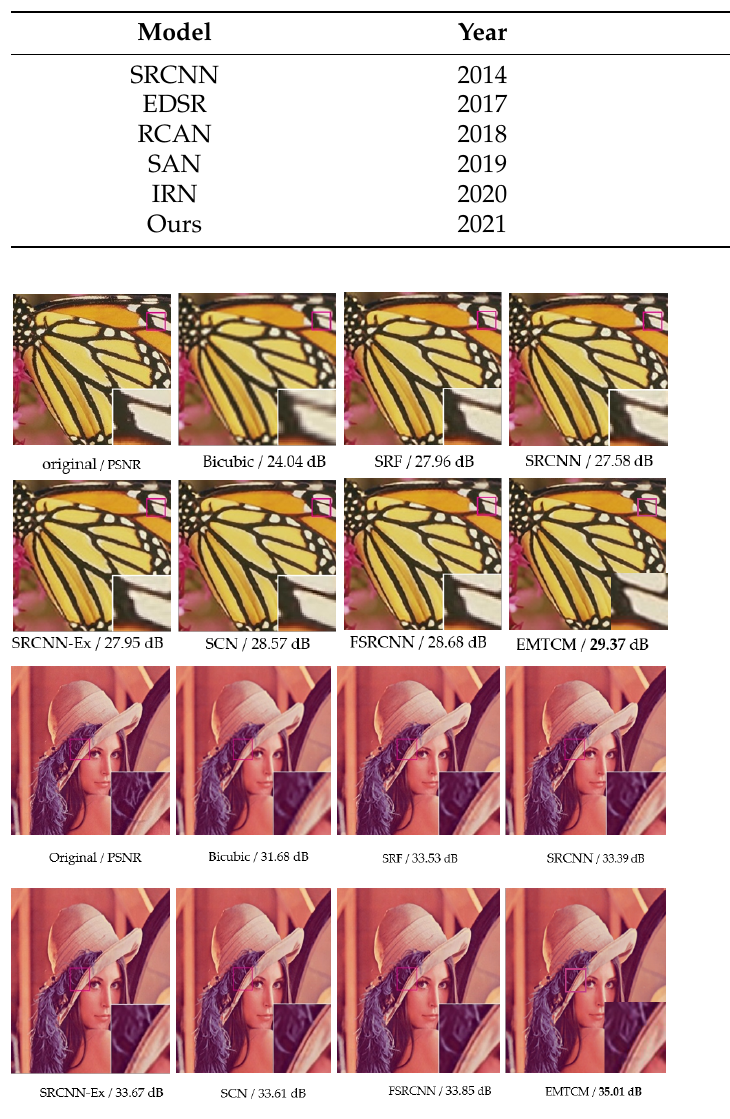
Table 5. Parameter comparison between our EMTCM and state-of-the-art methods to substantiate the efficacy of our method.